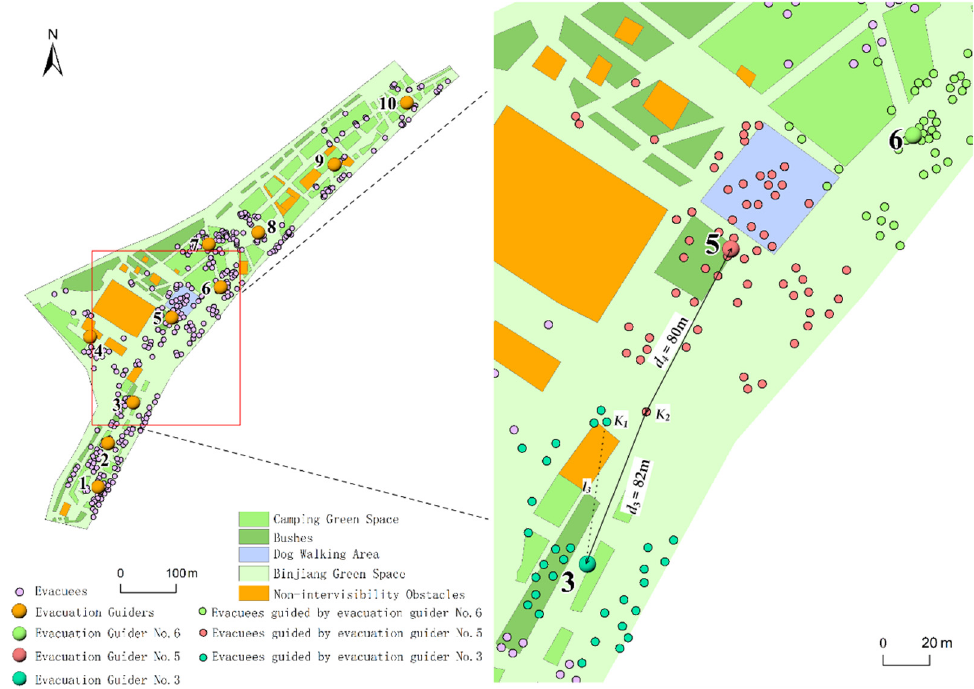
Figure 16. Schematic diagram of the allocation of the evacuation guiders, and the guiding relation between the guiders and the evacuees (based on k-means algorithm) at 9:30 on 5 May 2021.